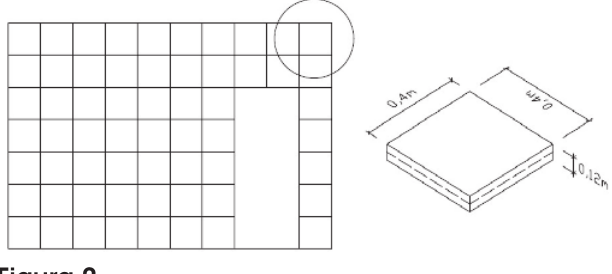
Discretização da parede em elementos de